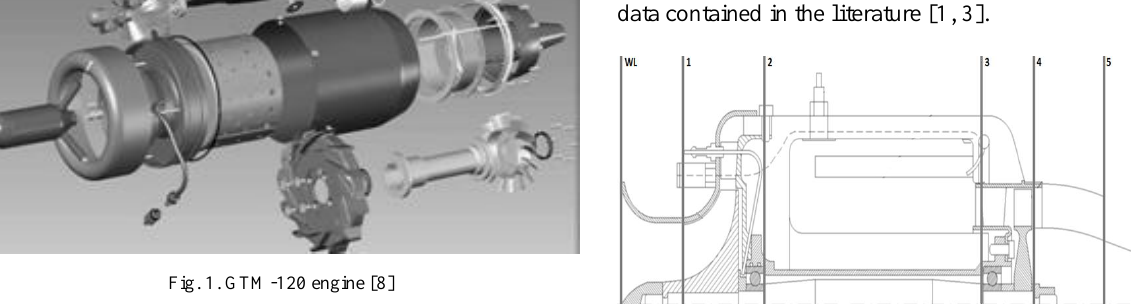
Fig. 1. GTM-120 engine [8]